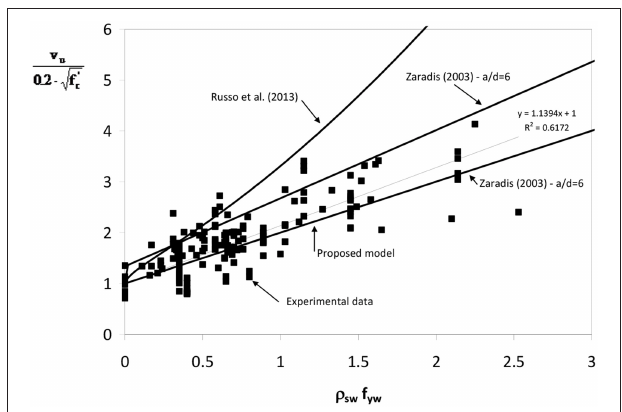
FIGURE 8 | Variation of the ultimate shear stress against ρ sw f sw